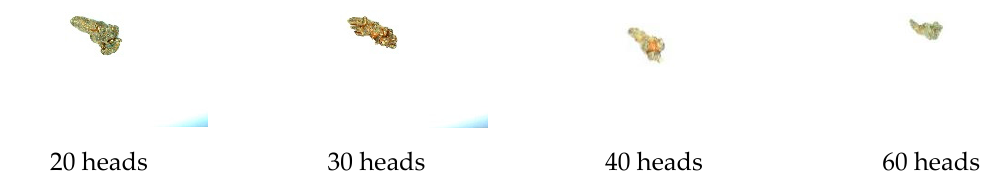
Figure 1. Schematic diagram of four different grades of Panax notoginseng .